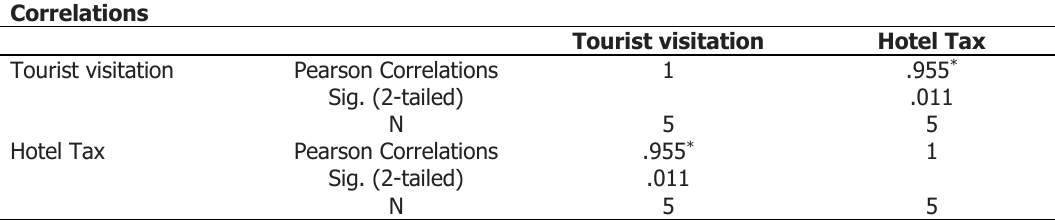
Table 3 . Correlation Coefficients of Variable X with Y2